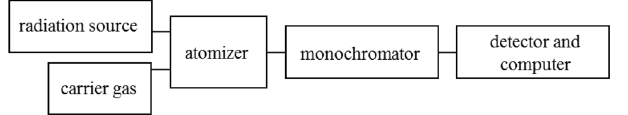
Figure 1. Block diagram of a typical instrument used for atomic absorption